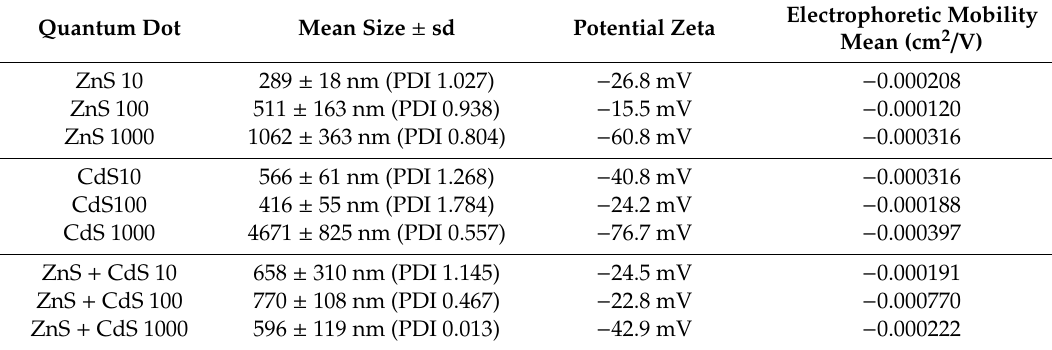
Table 2. Results from ICP-AES analysis of Zn and Cd in water samples.